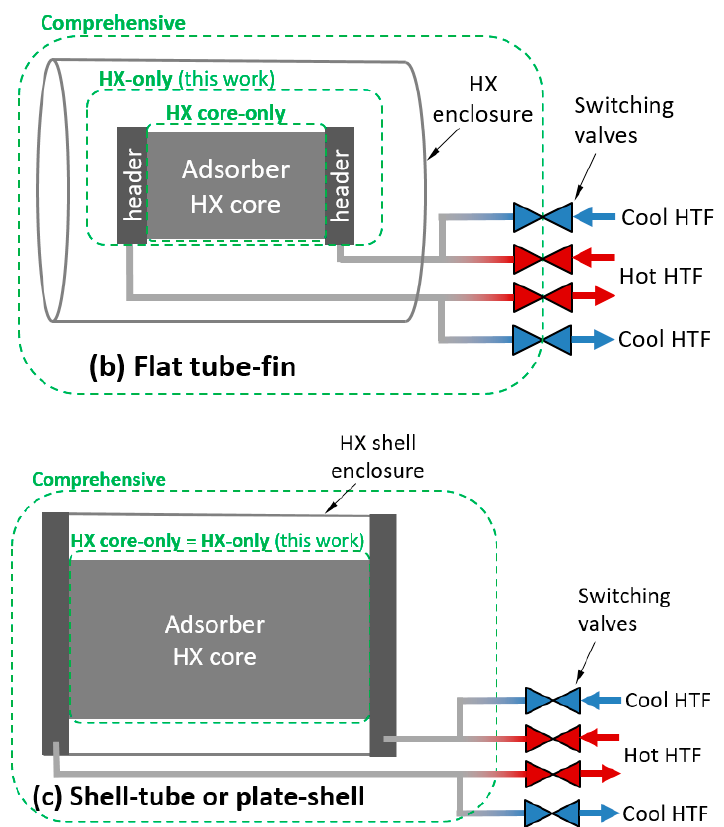
Figure 1. Illustration of control volumes and heat transfer fluid (HTF) relevant to thermal mass for: ( a ) round tube–fin; ( b ) flat tube–fin; and ( c ) shell–tube or plate–shell HXs.